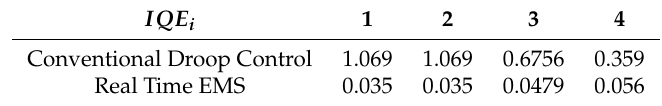
Figure 10. Frequency regulation performance with the real-time EMS. Unlike to the conventional droop control results (see Figure 8), the proposed real-time EMS achieves a proper frequency regulation performance as it was shown in the Proposition 2. Table 3. Frequency regulation performance: IQE index.